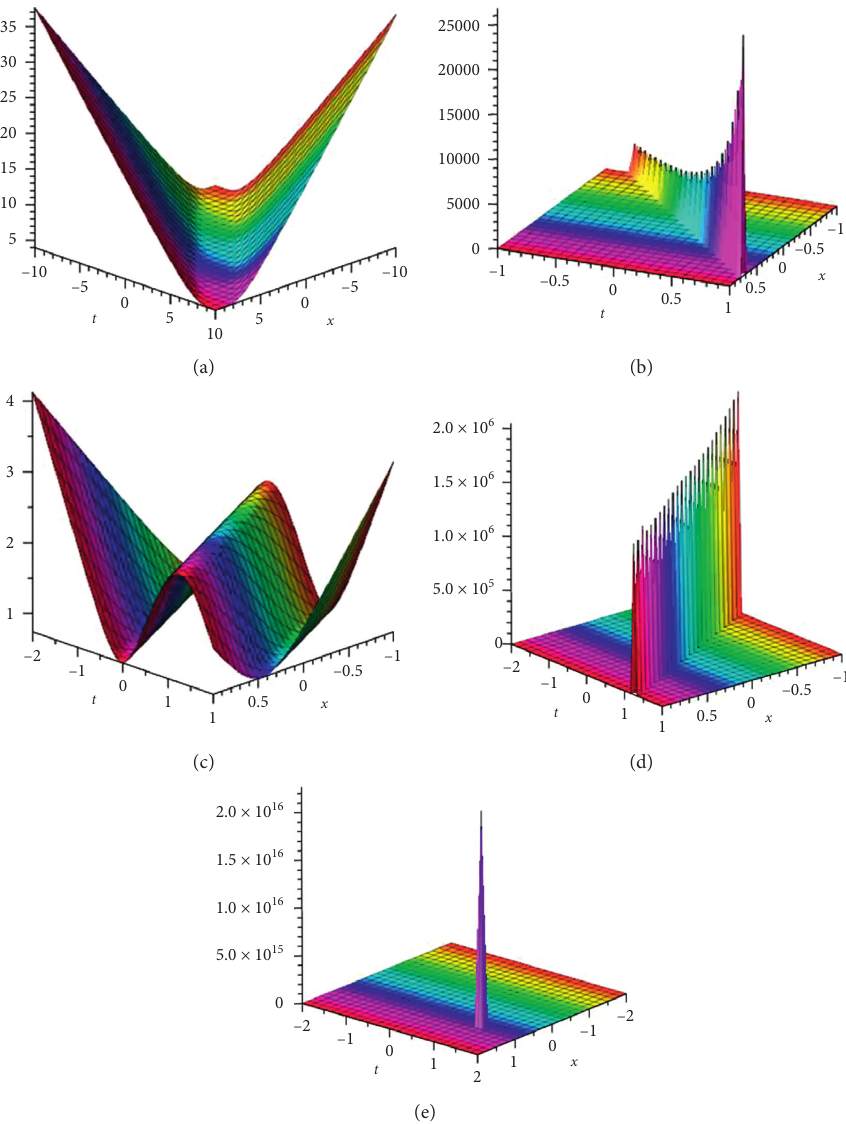
Figure 6: 3D profile of Family 18 with α � 1 . 5, β � 0, k � y � 1, ω � 0 . 5, p � q � 0 . 9, μ � 0 . 25, σ � − 1 . 5, and A � 2 . 5. (a) | Φ | . (d) | Φ | . (e) | Φ | (c) | Φ 28 29 30